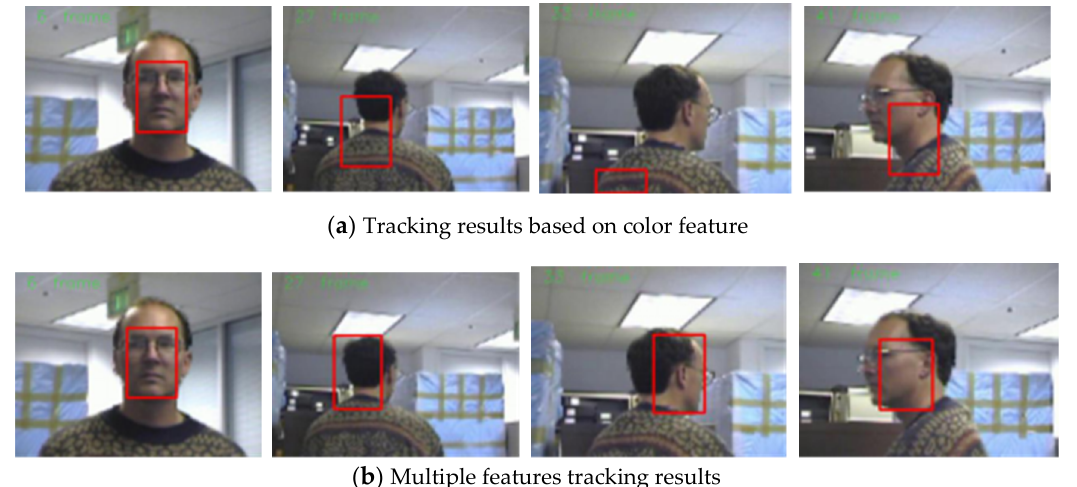
Figure 10. Tracking results under the background changes.